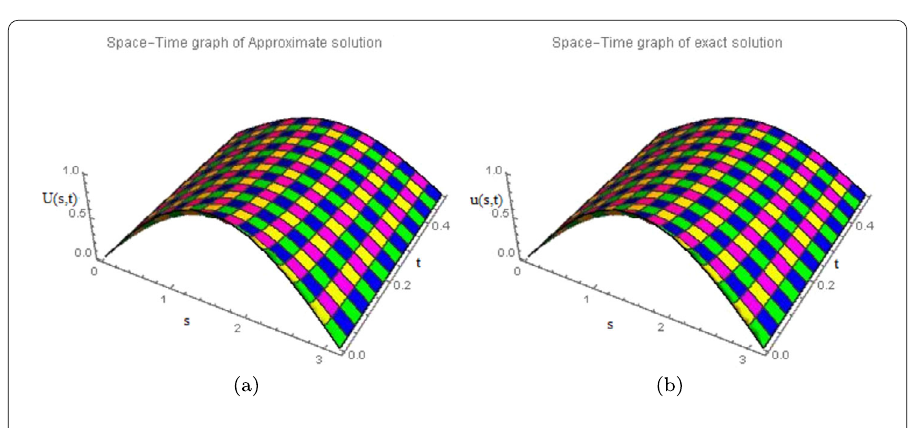
, t = 0.5 for Example 1 60